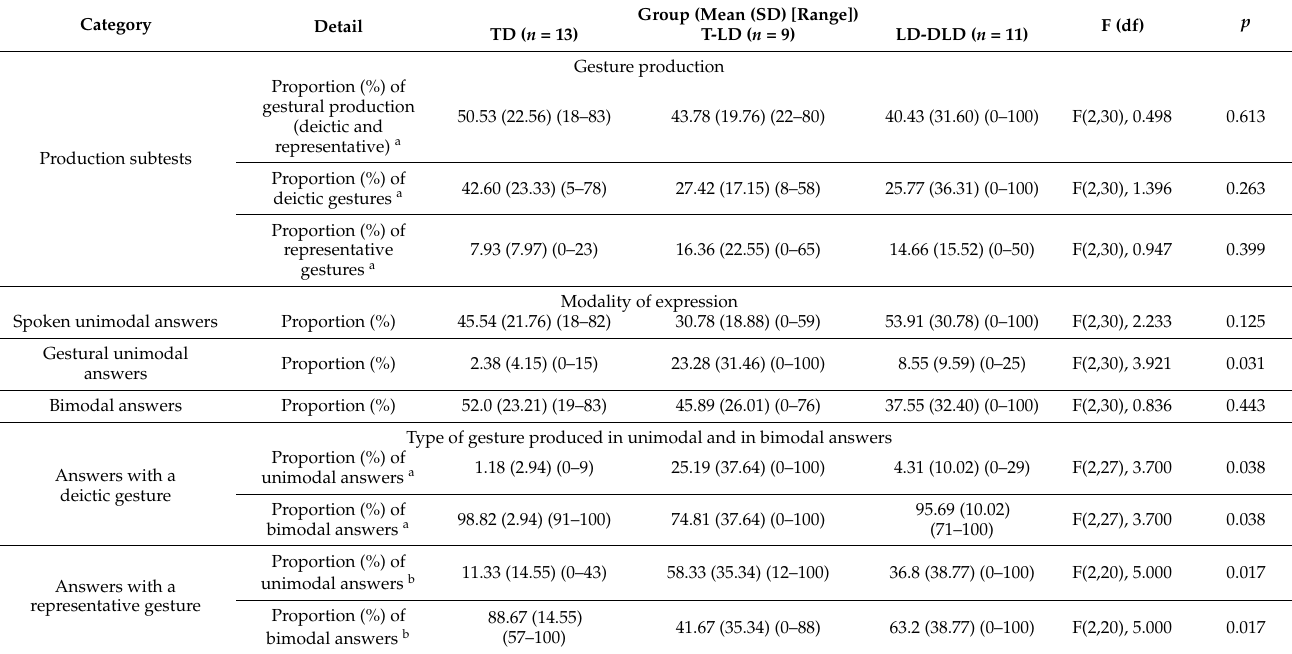
Table 4. Measures from the gestural